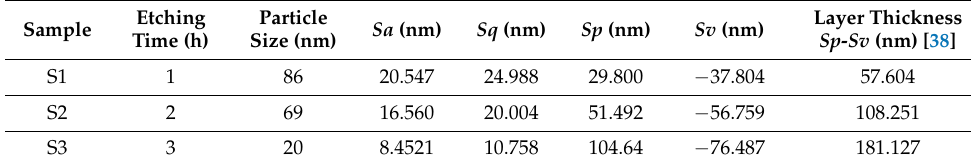
Table 2. Surface particle sizes, nano-roughness and layer thickness.